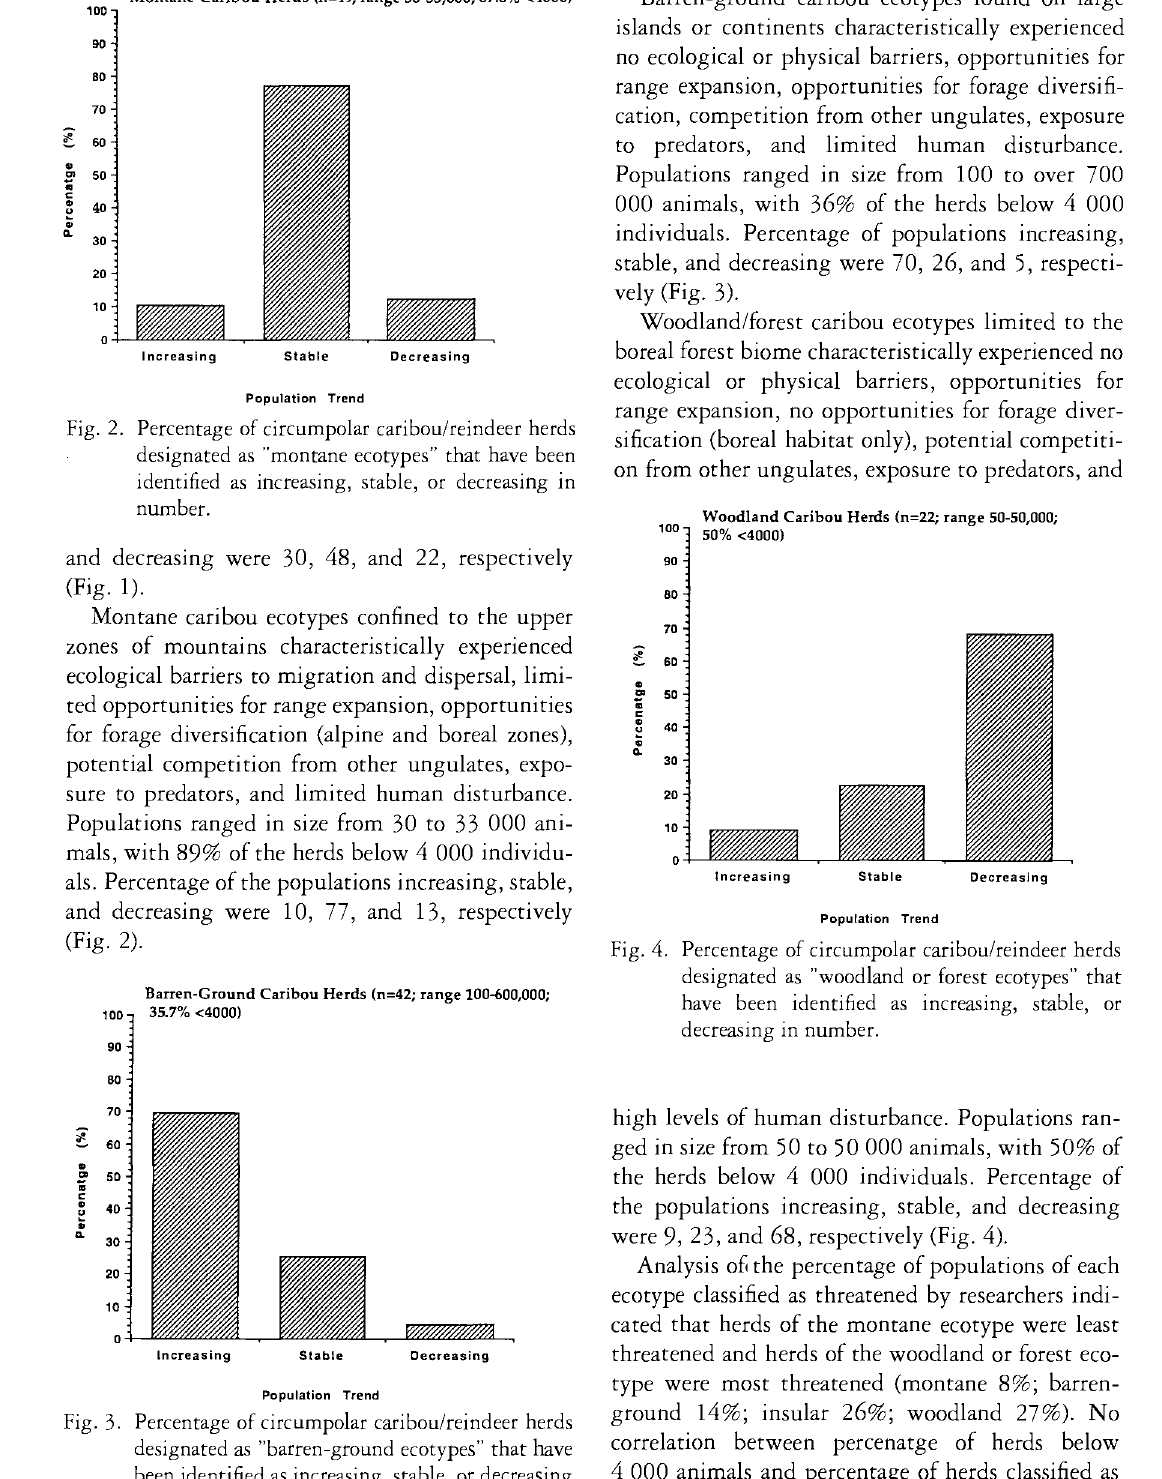
Fig. 3. Percentage of circumpolar caribou/reindeer herds designated as "barren-ground ecotypes" that have been identified as increasing, stable, or decreasing in number.